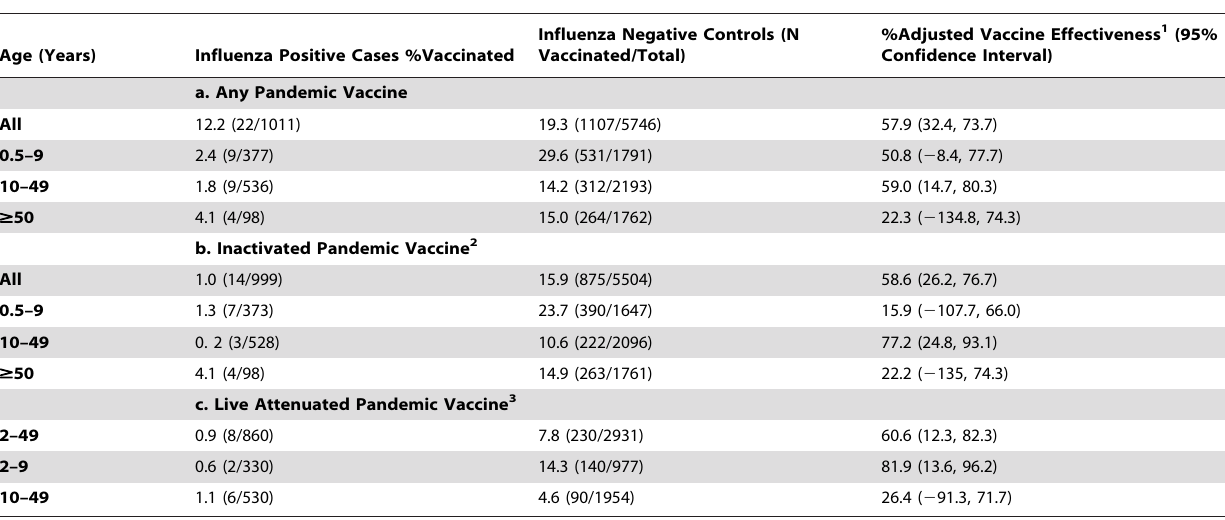
Age Group and Vaccine